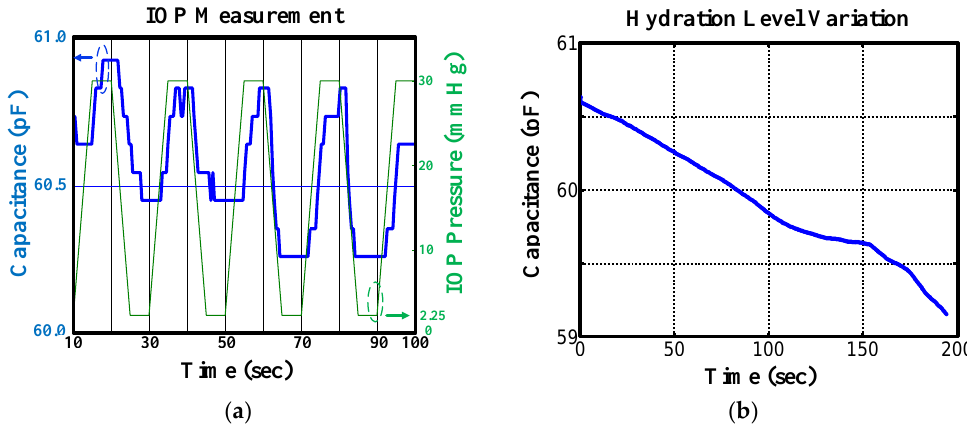
Figure 11. ( a ) Intraocular pressure (IOP) measurement results; ( b ) Hydration level measurement results. Table 2. A comparison of the intraocular pressure monitoring system in the present study with those used in previous studies.